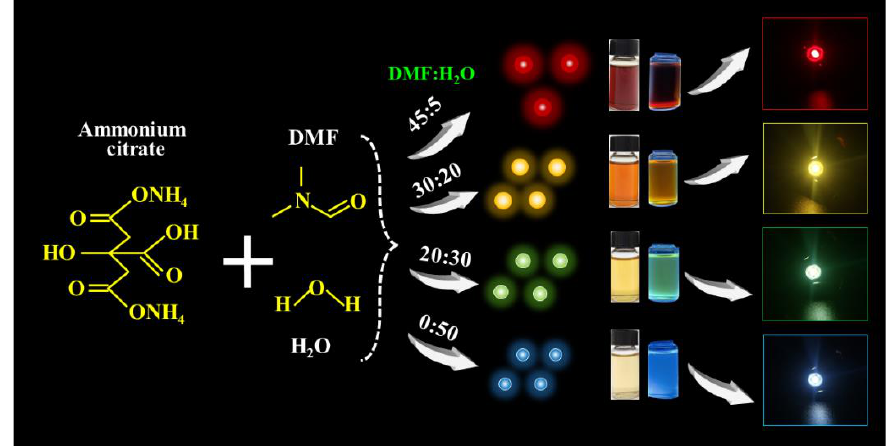
Figure 1. The procedures for the preparation of multicolor CDs and their application in